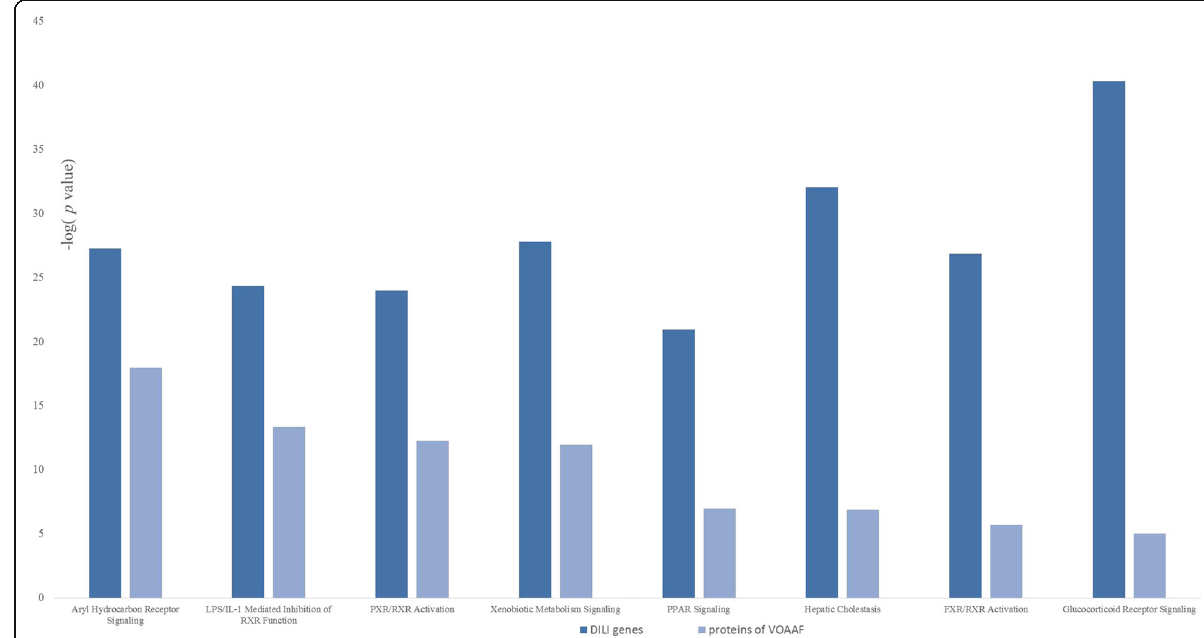
Fig. 5 The common pathways both involved in DILI genes and target proteins of